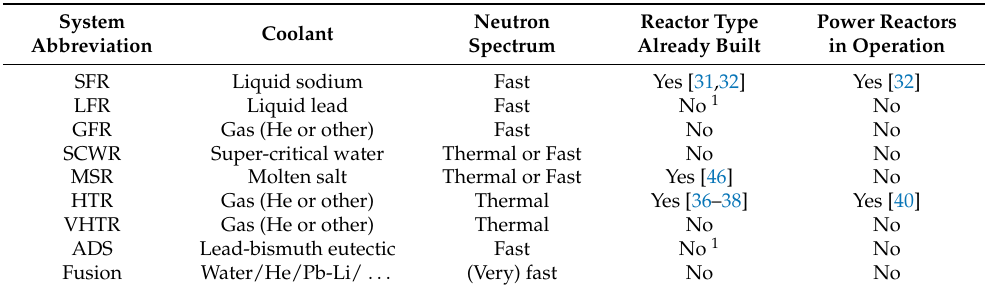
Table 1. Main features of next generation nuclear systems and existing experience, following GenIV- related nomenclature and references